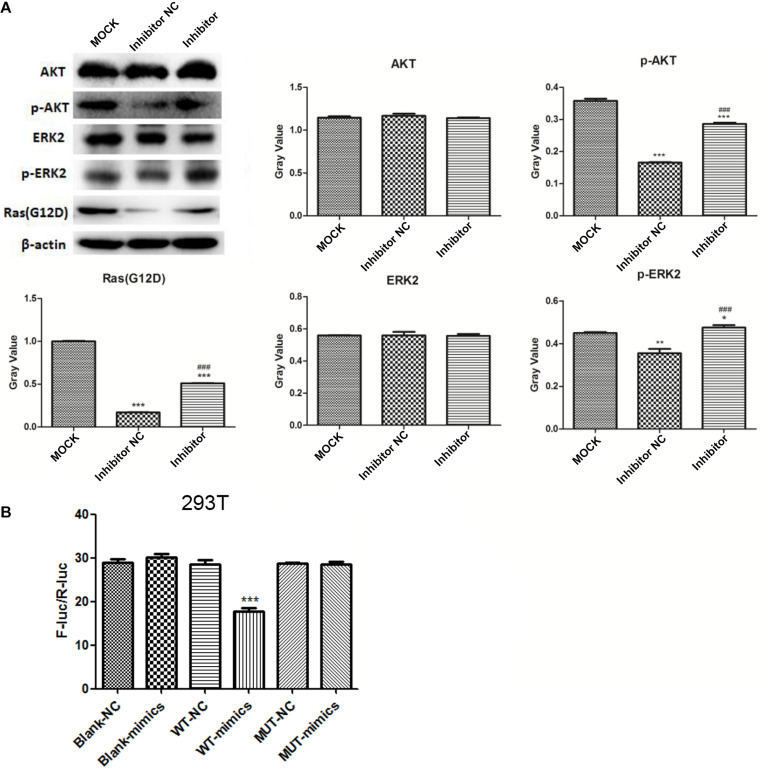
Western blot analysis of AKT, ERK2, p-AKT, p-ERK2, and RasG12D (A) *p < 0.05, **p < 0.01, and ***p < 0.001 compared to the MOCK group; ###p < 0.001 compared to the NC group. Dual-luciferase reporter gene assay results for the targeted combinatorial effect between the lncRNA RP11-363N22.3s and hsa-miR-143-3p (B). ***p < 0.001 compared to the NC group. MOCK: CFPAC-1 only (without MSC exosome); Inhibitor NC: CFPAC-1 + MSC-hsa-miR-143-3p inhibitor negative control; Inhibitor: CFPAC-1 + MSC-miR-143 inhibitor group.